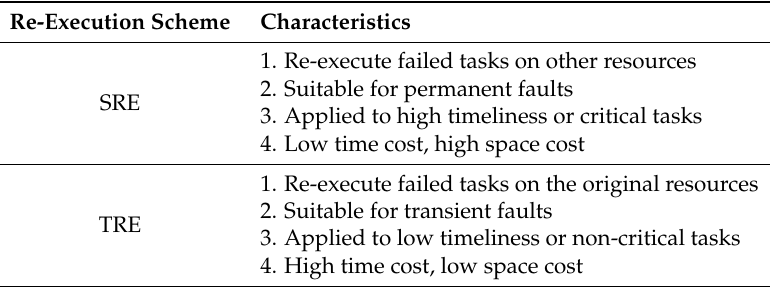
Table 3. The comparison of re-execution